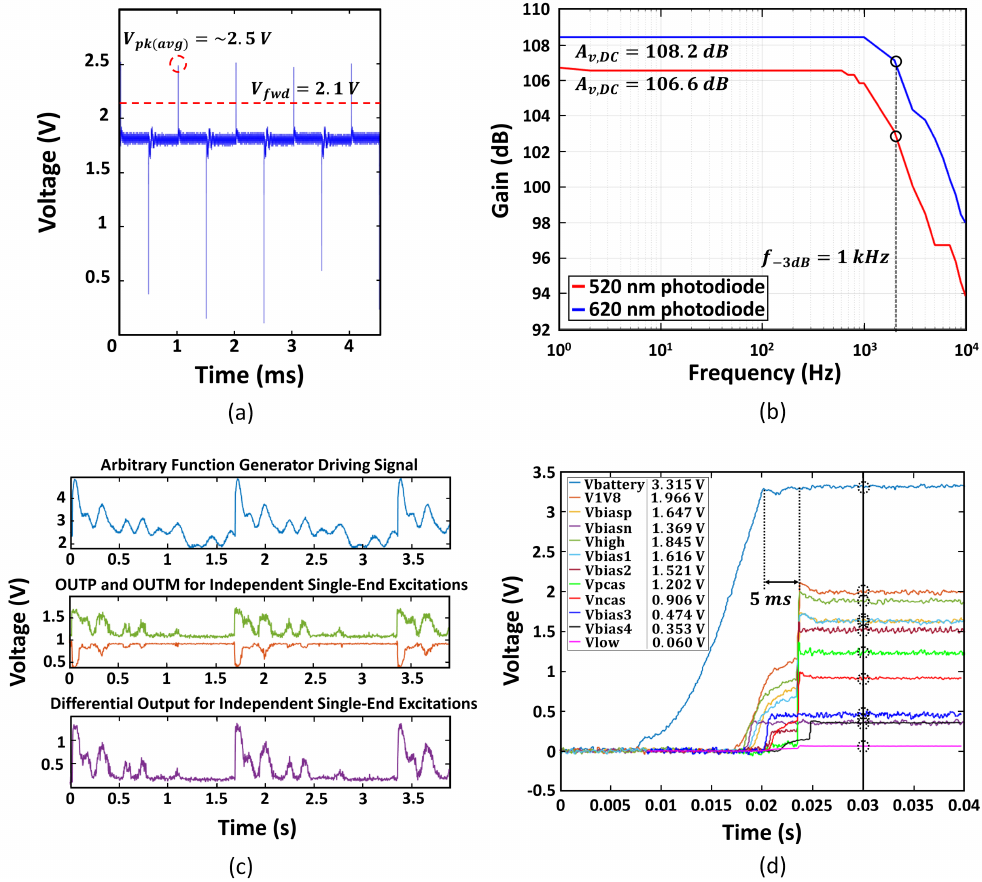
Figure 9. ( a ) Voltage at V LED node, ( b ) TIA bode plot for single-ended excitation, ( c ) waveform driving external LEDs, single-ended outputs, and differential output signal from AFE, ( d ) voltages generated by the BMR and the bias